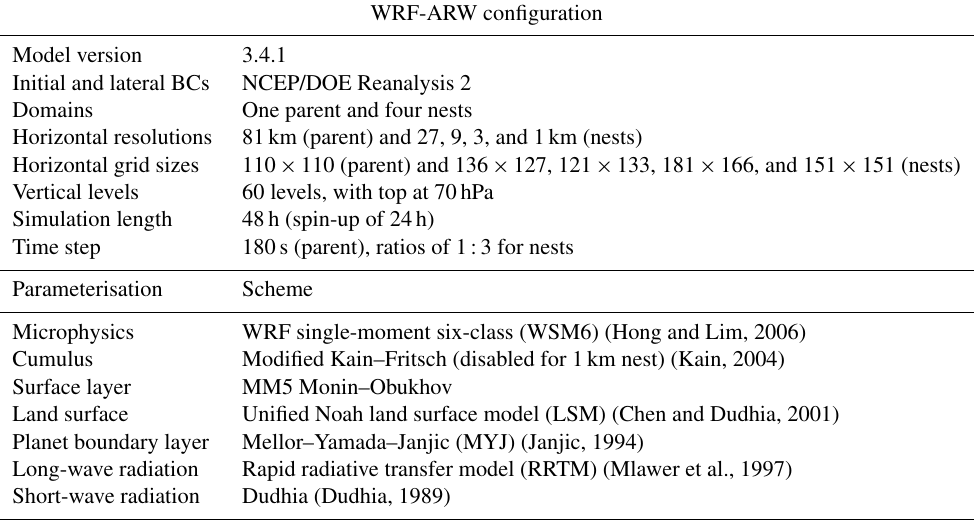
Table 2. WRF-ARW model configuration and physical parameterisations used for the 1986 Lake Nyos